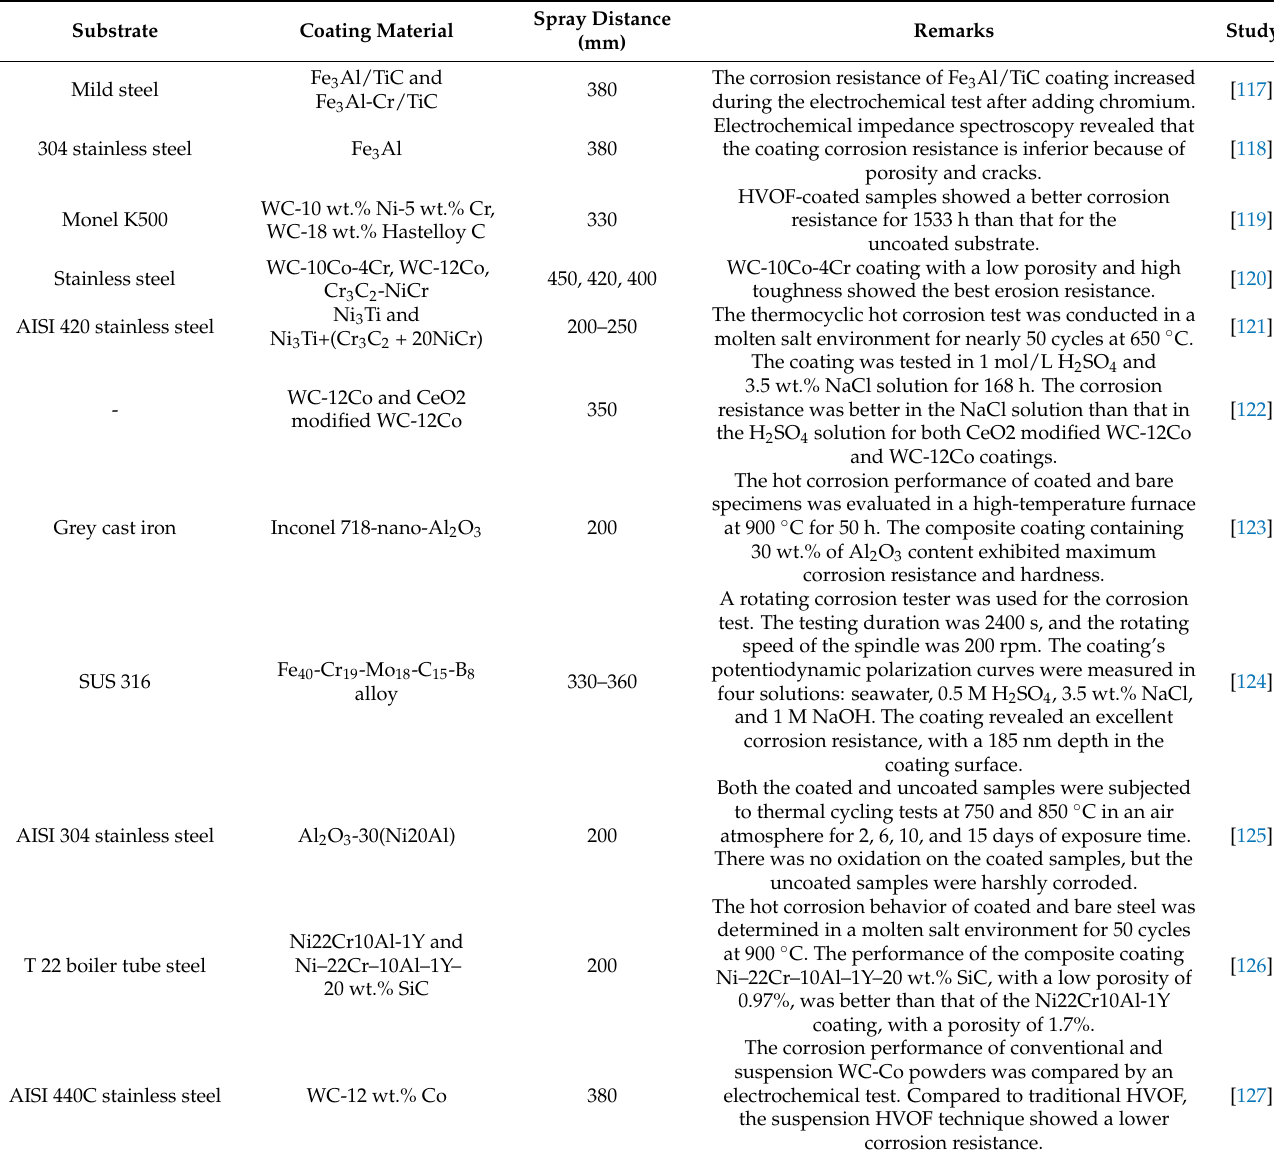
Table 2. Summary of coating materials and spray distances used in